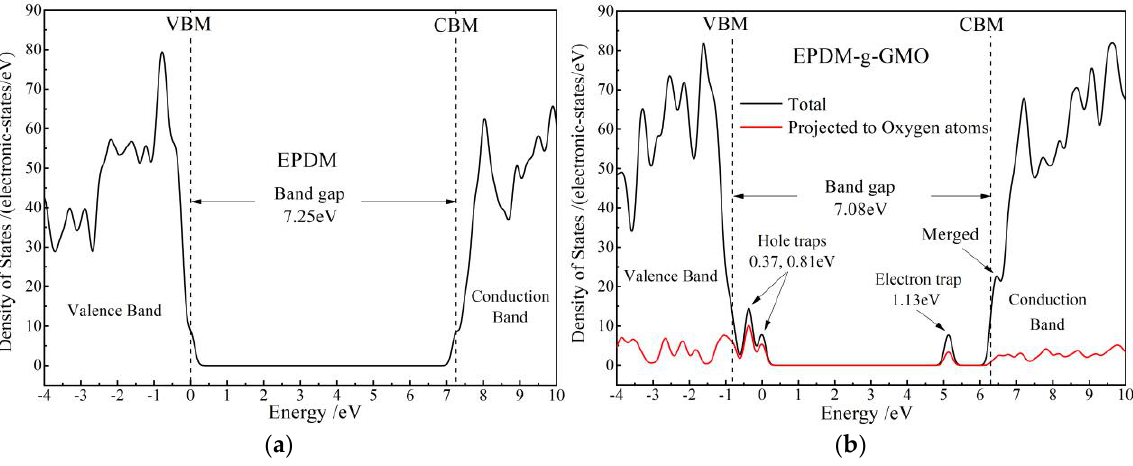
Figure 8. Densities of electronic states of ( a ) EPDM and ( b ) EPDM-g-GMO polymeric molecules.